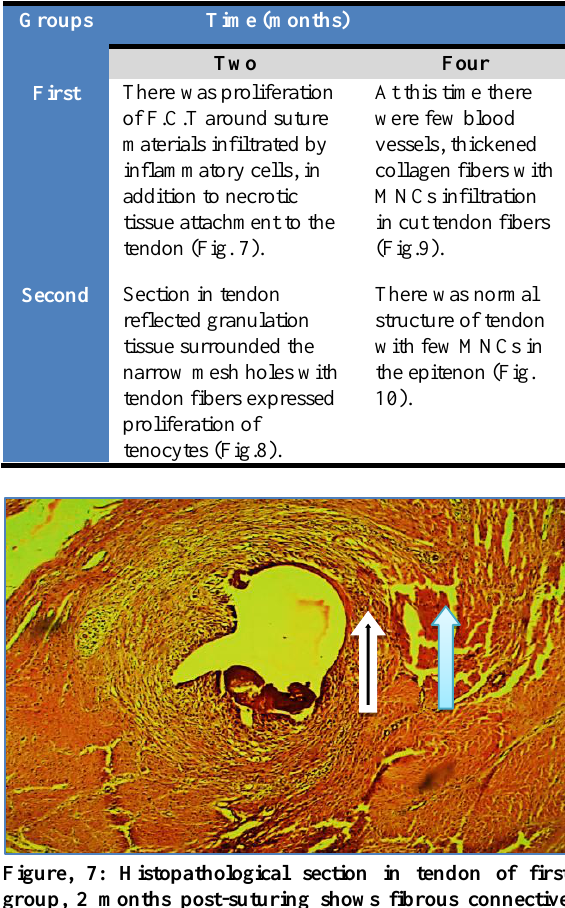
Table, 4: Microscopical findings in first and second groups.